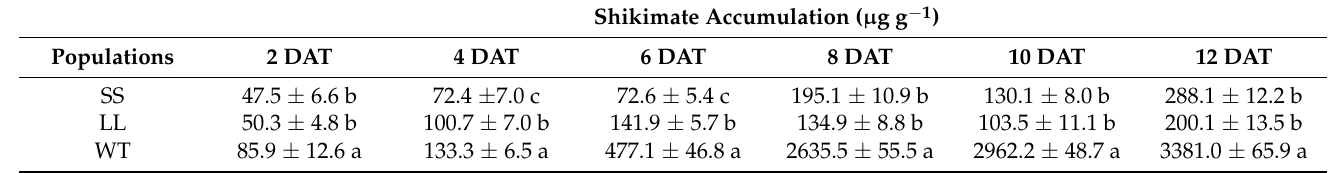
Table 2. Shikimate accumulation in the leaf tissues of three populations at different days after glyphosate treatment under a dose of 1800 g ae ha − 1 . Letters indicates differences among values according to Student’s t -test at p < 0.05. Data are means ± standard error of four replicates samples. Shikimate Accumulation ( µ g g − 1 ) Populations 2 DAT 4 DAT 6 DAT 8 DAT 10 DAT 12